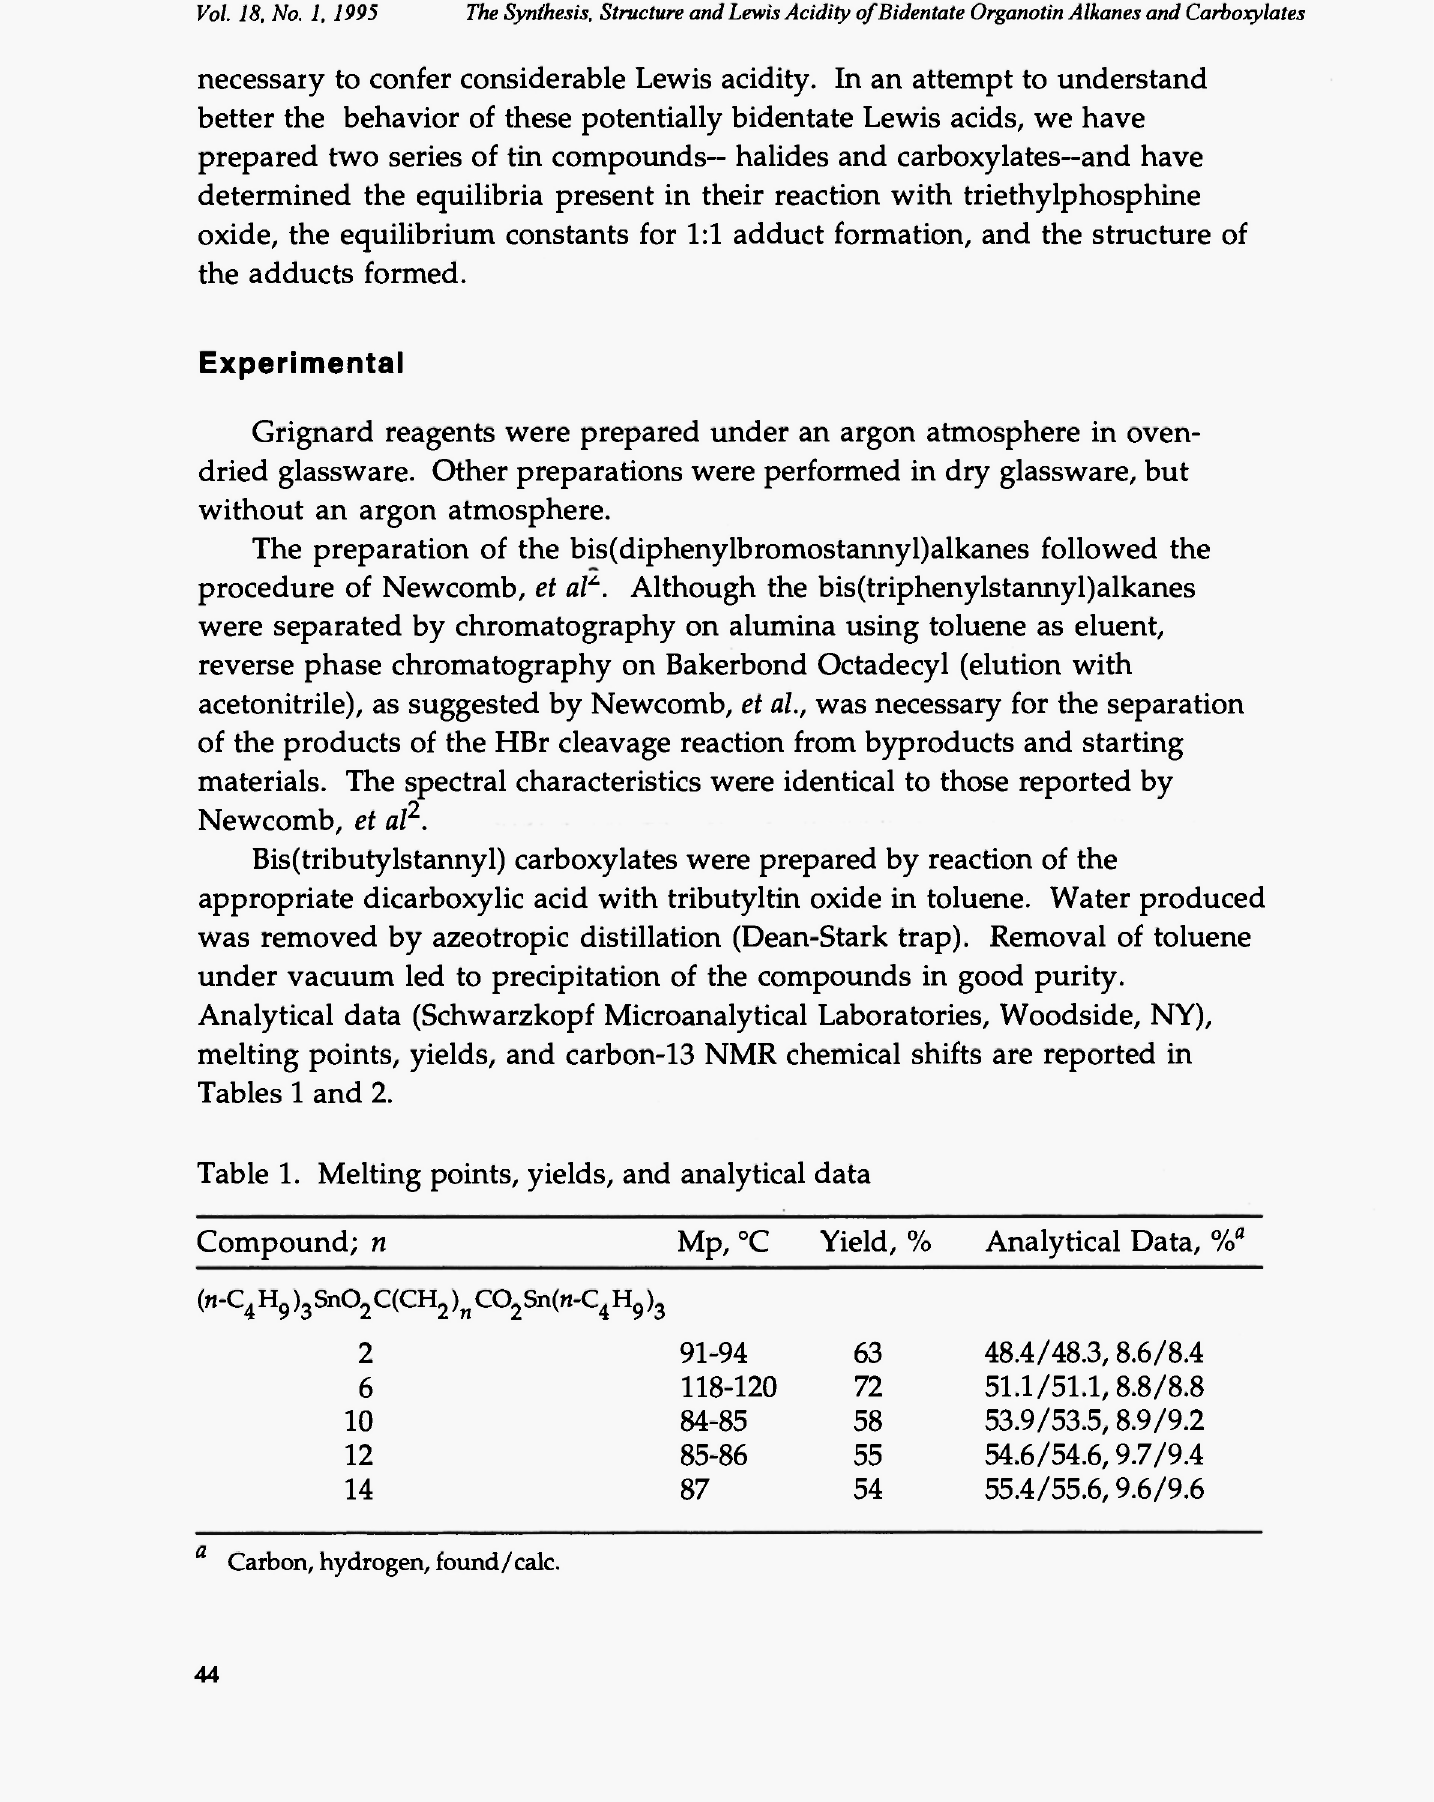
Table 1. Melting points, yields, and analytical data Compound; η Mp, °C Yield, % Analytical Data, %